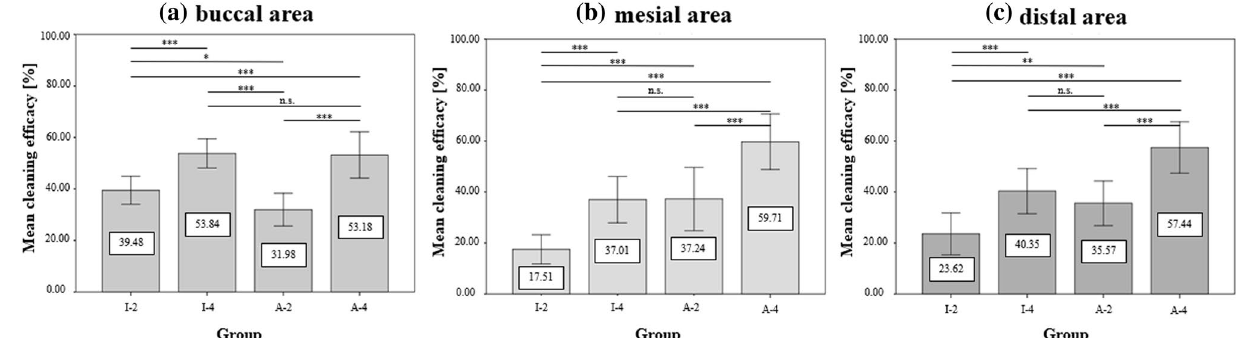
Figure 5. The means and standard deviation of the cleaning efficacy of the buccal ( a ), mesial ( b ) and distal ( c ) areas. Horizontal lines with “***” describe significant differences with p < 0.001, “**” with p < 0.01, and “*” with p < 0.05 between the I-Prox P brush applied for two (I-2) and four seconds (I-4) and the AirFloss with two (A-2) and four sprays (A-4). “n.s.” indicates no significant